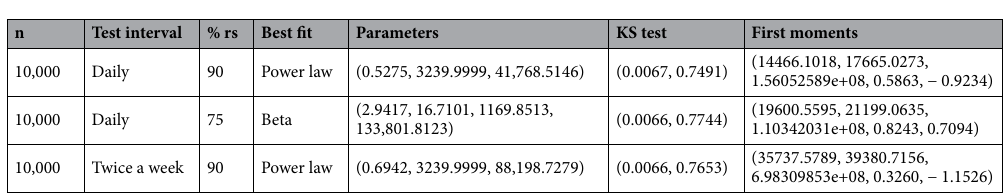
Table 3. Statistics of testing-isolated strategies in the array of (60, 60). Percentage of random sample (% rs). Estimated parameters (a, b, loc, scale). KS goodness-of-fit test (D, p-value). First moments (median, mean, variance, skewness, kurtosis).